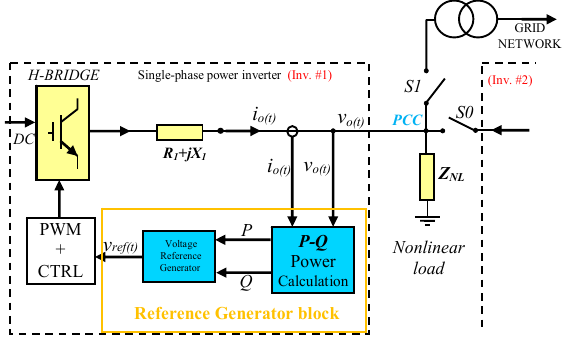
Figure 1. Simplified scheme of a single-phase voltage source inverter (VSI) (Inv. #1) sharing a nonlinear load with a second inverter (Inv. #2), showing the Reference Generator Block that contains the active and reactive averaged powers (P–Q) calculation and the voltage reference generator for the pulse-width modulation (PWM) and control (CTRL) block (PWM + CTRL).